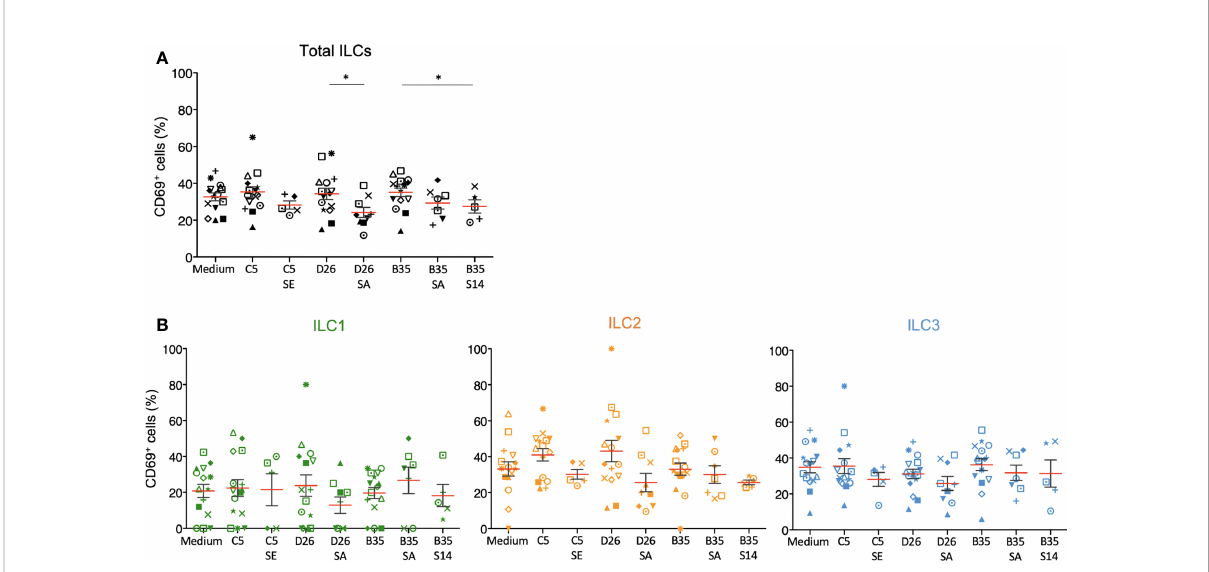
FIGURE 6 Phenotypic pro fi le by ILCs after NAb-HAdV uptake. CD69 levels were quanti fi ed 24 h post-challenge for each HAdV ± NAb complex for (A) total ILCs and (B) the ILC subsets (n ≥ 5). Sera “ E ” , “ A ” , and “ 14 ” inhibit HAdV-C5, -D26, or -B35, respectively, uptake by epithelial cells. Statistical analyses were performed using paired Student ’ s t test by comparing uninfected cells and cells challenged with the HAdVs (ns = p > 0.05, * p ≤